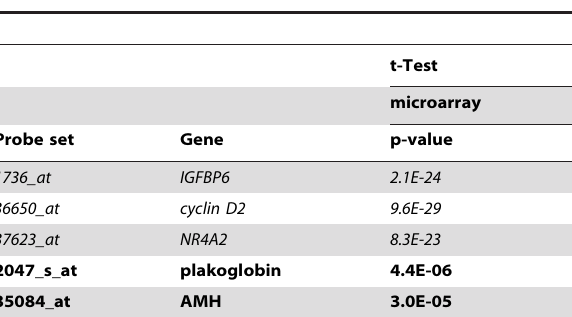
Table 2. Genes regulated by the HH pathway in other systems were differentially expressed in GN relative to NB, consistent with observed HH activity in